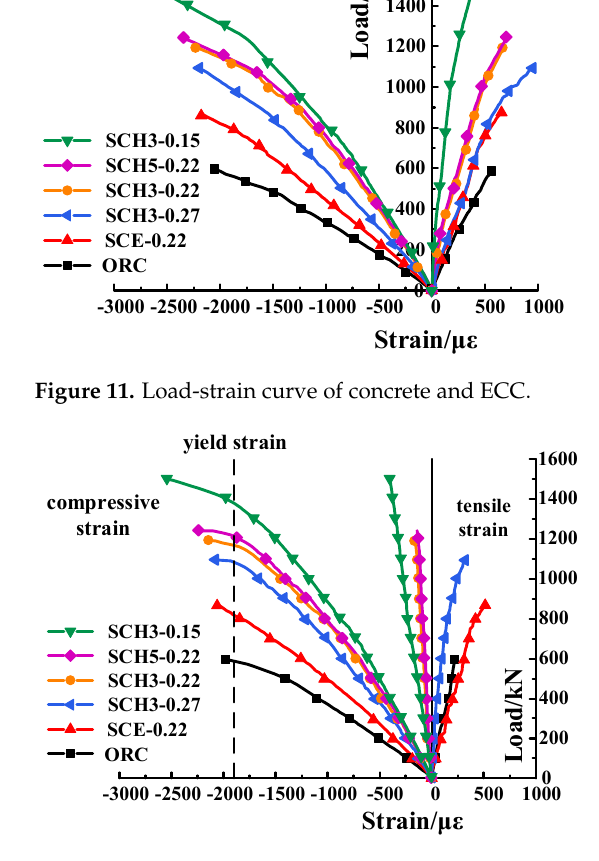
Figure 12. Rebar load-strain curve of tested specimens.